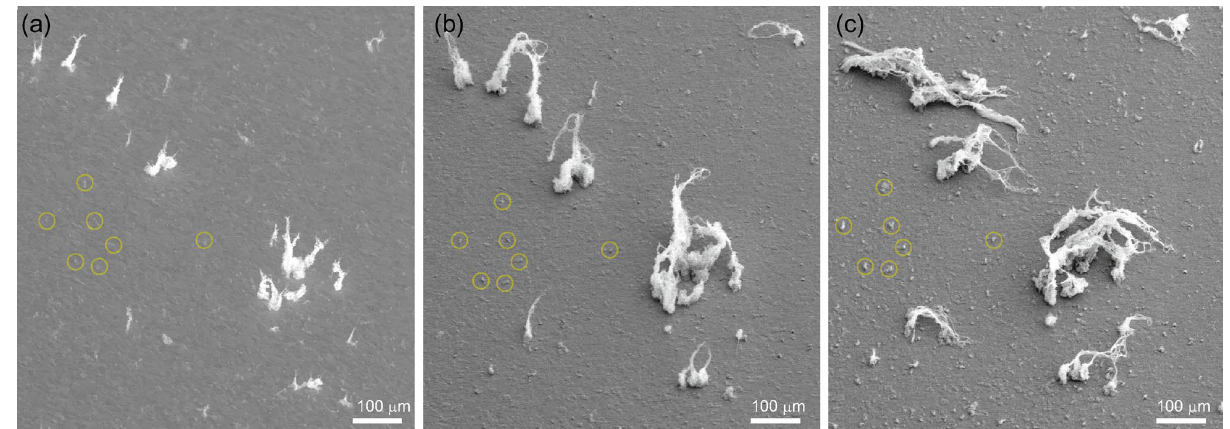
Figure 8. SEM images of ( a ) the NTB-formed W sample surface and ( b , c ) after He–W co-deposition for ( b ) 15 min and ( c ) 30